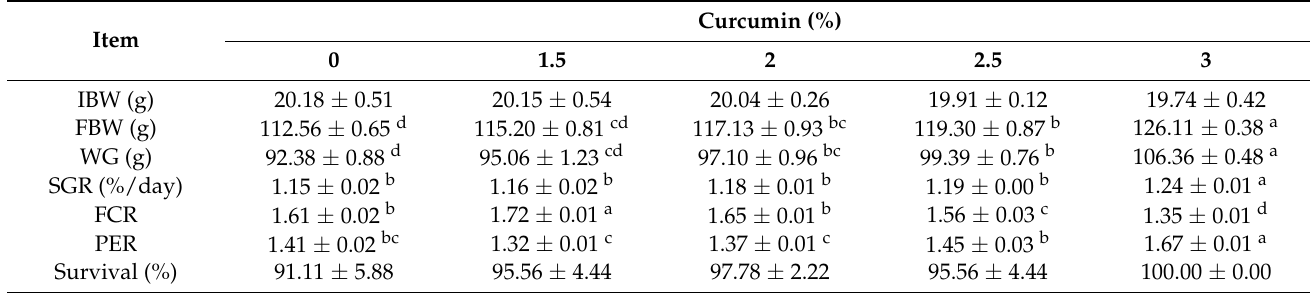
Values in the same row with different letters are significantly different ( p < 0.05) ( n = 3). IBW: initial body weight (g), FBW: final body weight (g), WG: weight gain (g), SGR: specific growth rate, FCR: feed conversion ratio, PER: protein efficiency